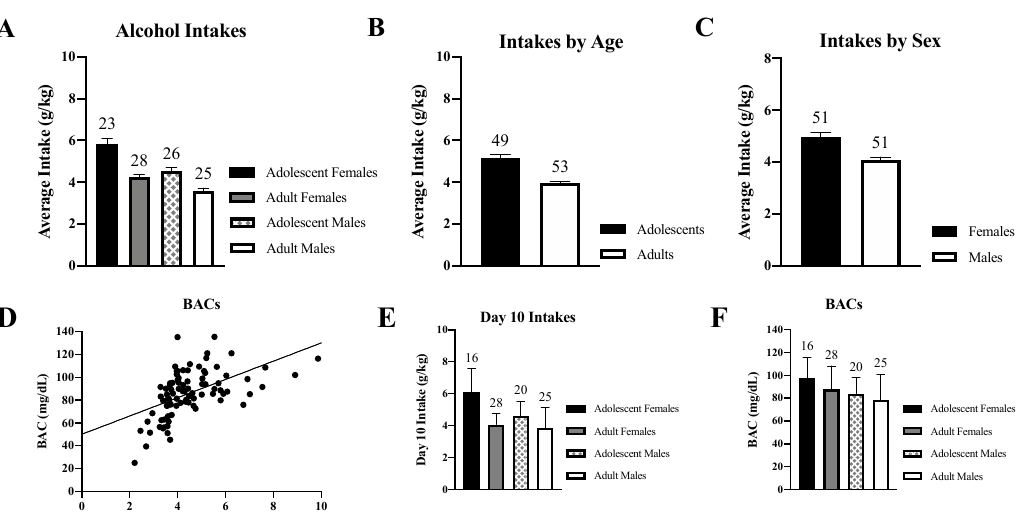
Figure 2. Summary of group differences in alcohol intake under our Drinking-in-the-Dark (DID) procedures. ( A ) Comparison of the average alcohol intake (g/kg) of the adult and adolescent male and female mice over the course of the 14-day drinking period. ( B ) Data from 1a, collapsed across Sex to illustrate the main Age effect detected by ANOVA. ( C ) Data from 1a, collapsed across Age to illustrate the main Sex effect detected by ANOVA. ( D ) Correlation between alcohol intake and BACs collected on Day 10 of drinking. ( E ) Comparison of group differences in alcohol intake on Day 10 of drinking when blood was sampled. ( F ) Comparison of group differences in the average BACs attained on Day 10 of drinking. The data represent the means ± SEMs for the numbers of mice indicated in each panel.